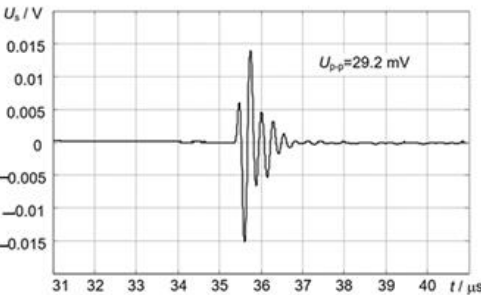
Figure 9. Waveform of the ultrasonic pulse obtained in a pulse echo mode in a liquid lead bismuth alloy at 290 °C.